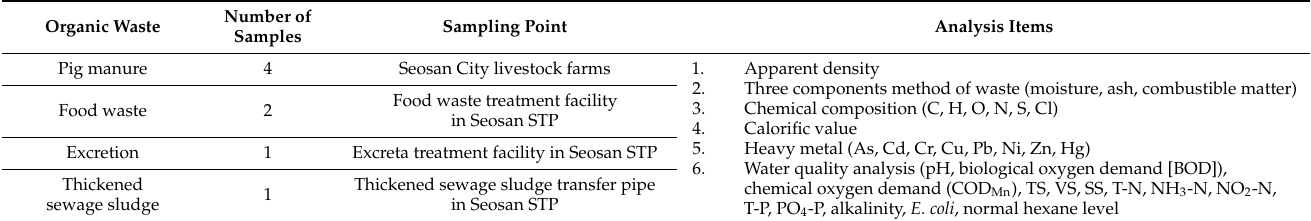
Table 2. Organic waste sample investigation items.